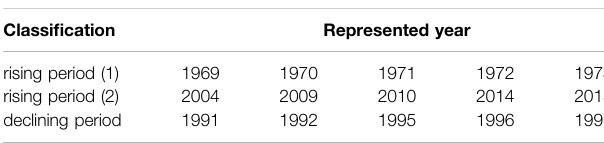
TABLE 4 | High-frequency and low-frequency dust